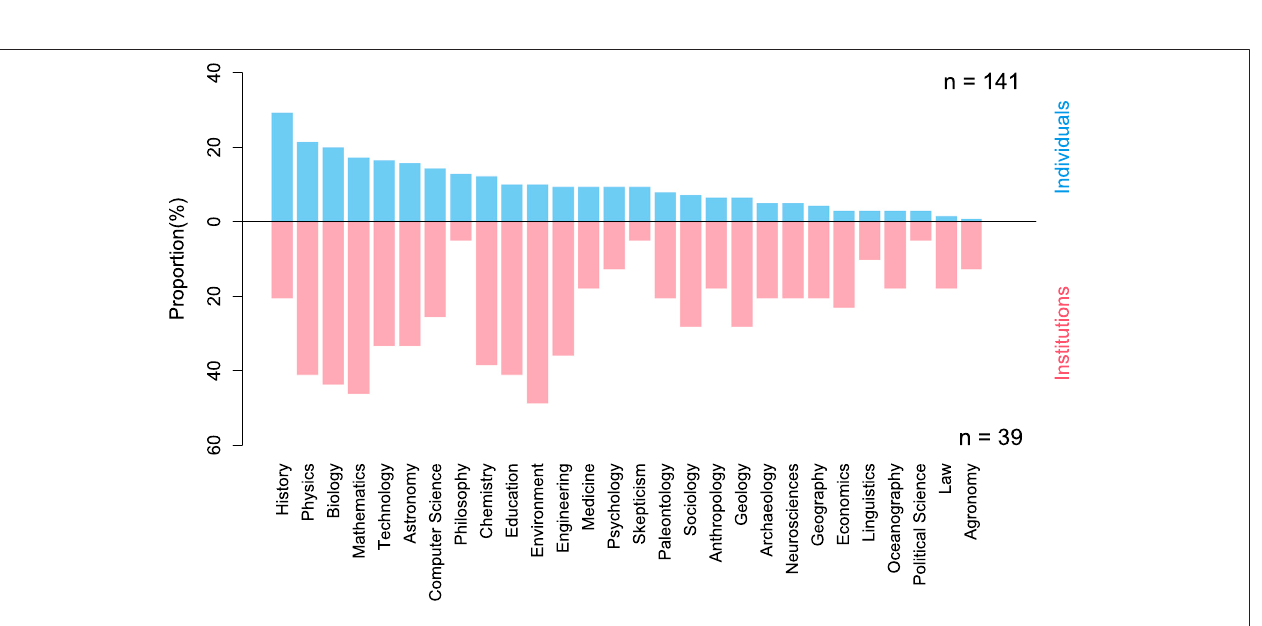
FIGURE 5 | Proportion of channels treating each scienti fi c